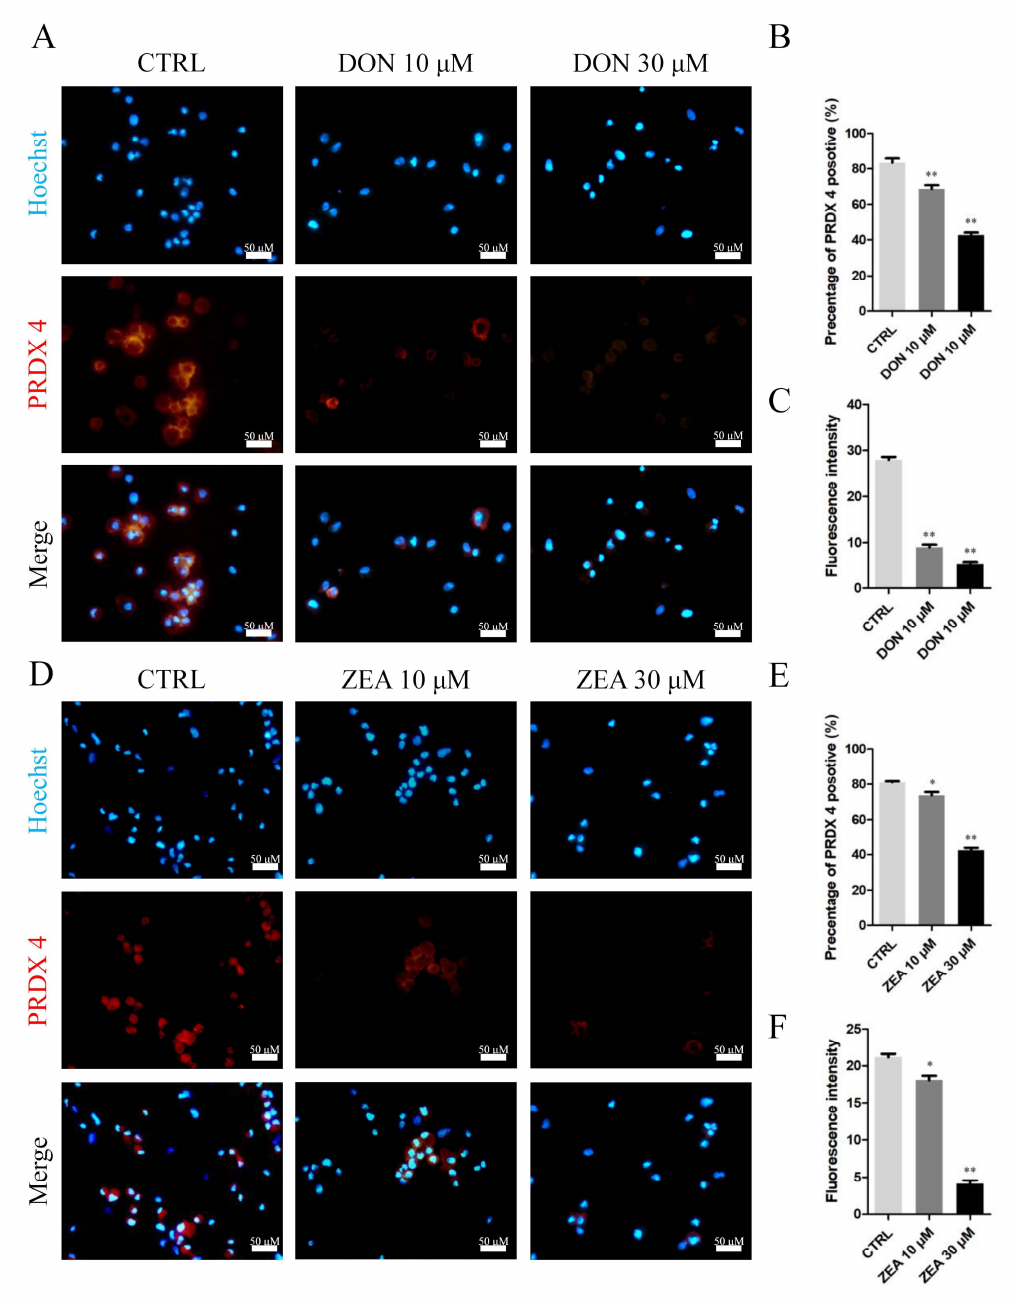
Figure 13. Immunofluorescence assay probing the expression of SC phosphor- PRDX4 proteins in the DON ( A ) and ZEA ( D ) treatment groups. The percentages of positive cells ( B , E ) and fluorescence intensity ( C , F ) were analysed. Bar indicates 50 μm. Data are presented as the means ± SD. * p < 0.05; ** p < 0.01.